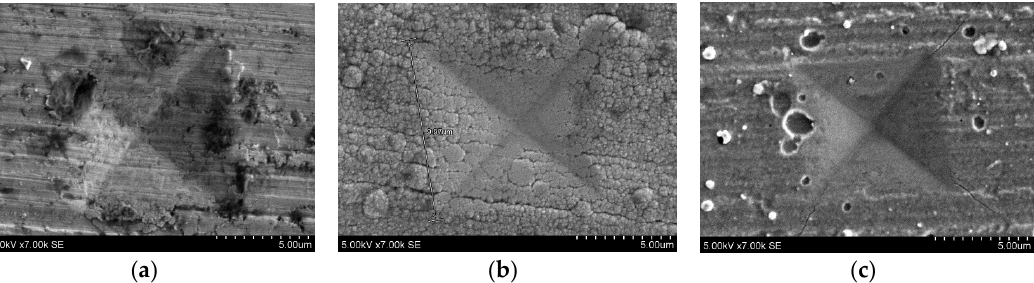
Figure 5. Trace of the Vickers indenter on surfaces (50 mN, ×7000): ( a ) Uncoated hard metal WC-Co; ( b ) With CrN coating; ( c ) With TiAlN coating.